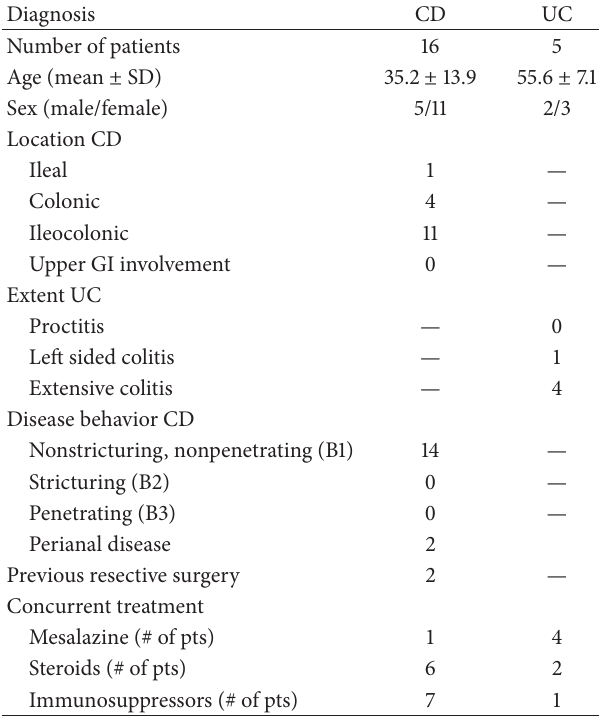
Table 1: Demographic and clinical characteristic of enrolled